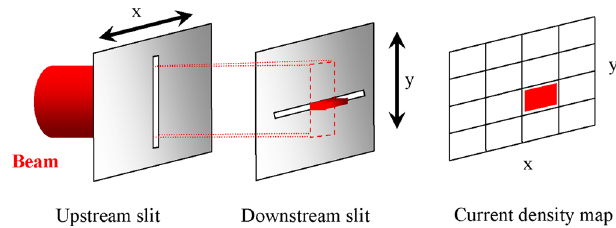
FIG. 7. (Color) Schematic illustrating the current density map- ping